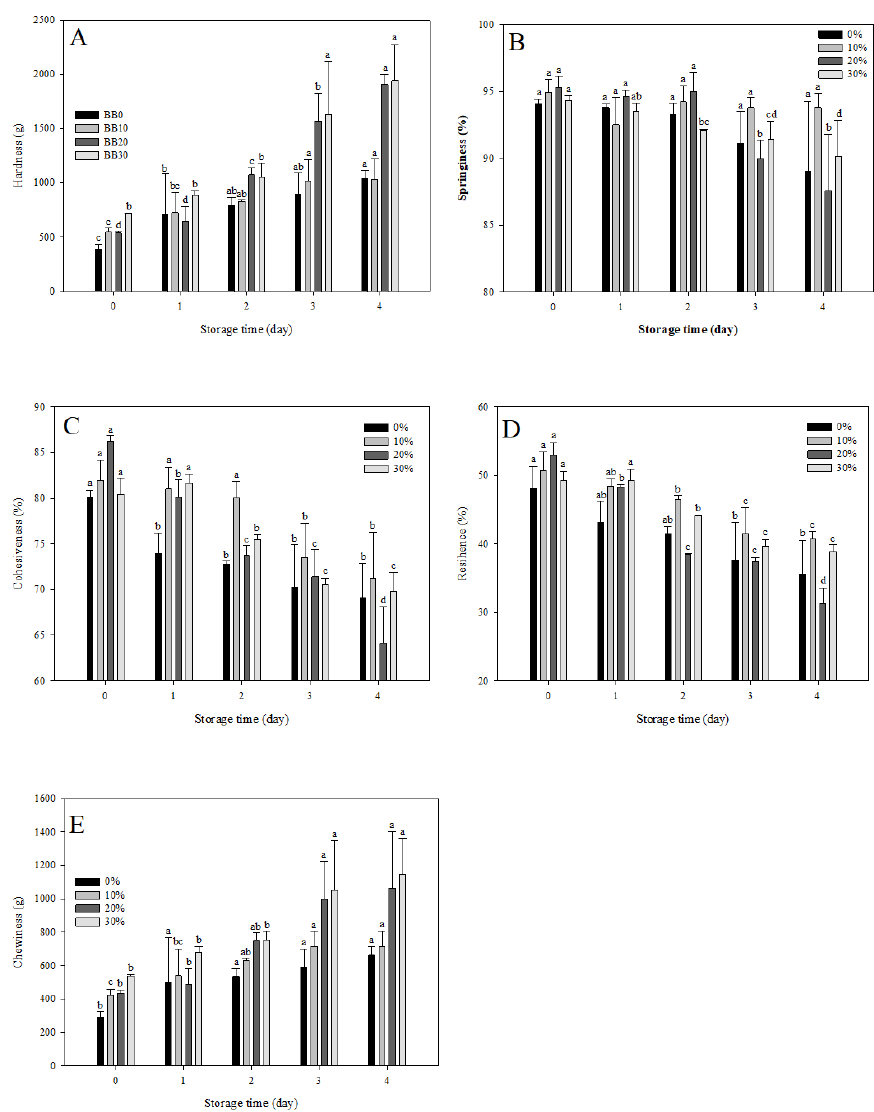
Figure 3. ( A ) Hardness, ( B ) springiness, ( C ) cohesiveness, ( D ) resilience, and ( E ) chewiness of different black rice sourdough powder proportions of black rice sourdough bread during storage. BB0: without black rice sourdough powder; BB10: with 10% black rice sourdough powder; BB20: with 20% black rice sourdough powder; and BB30: with 30% black rice sourdough powder. a–d: Data with the identical letter in the same column are not significantly different ( p < 0.05).